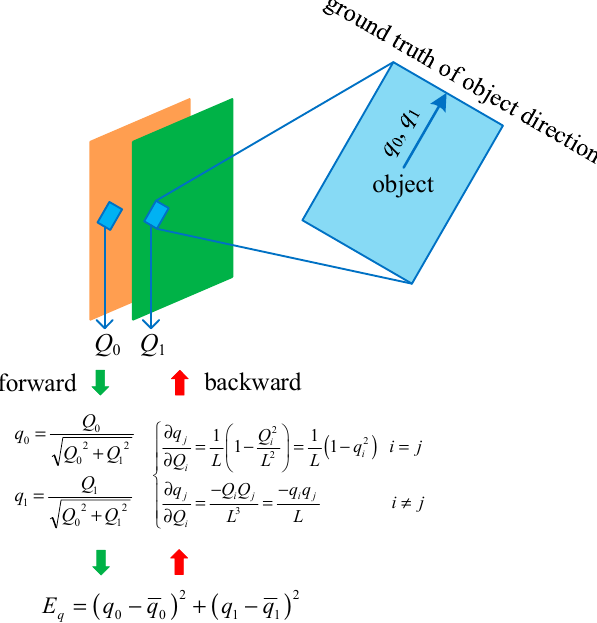
Figure 4. The forward–backward propagation object’s direction calculation.